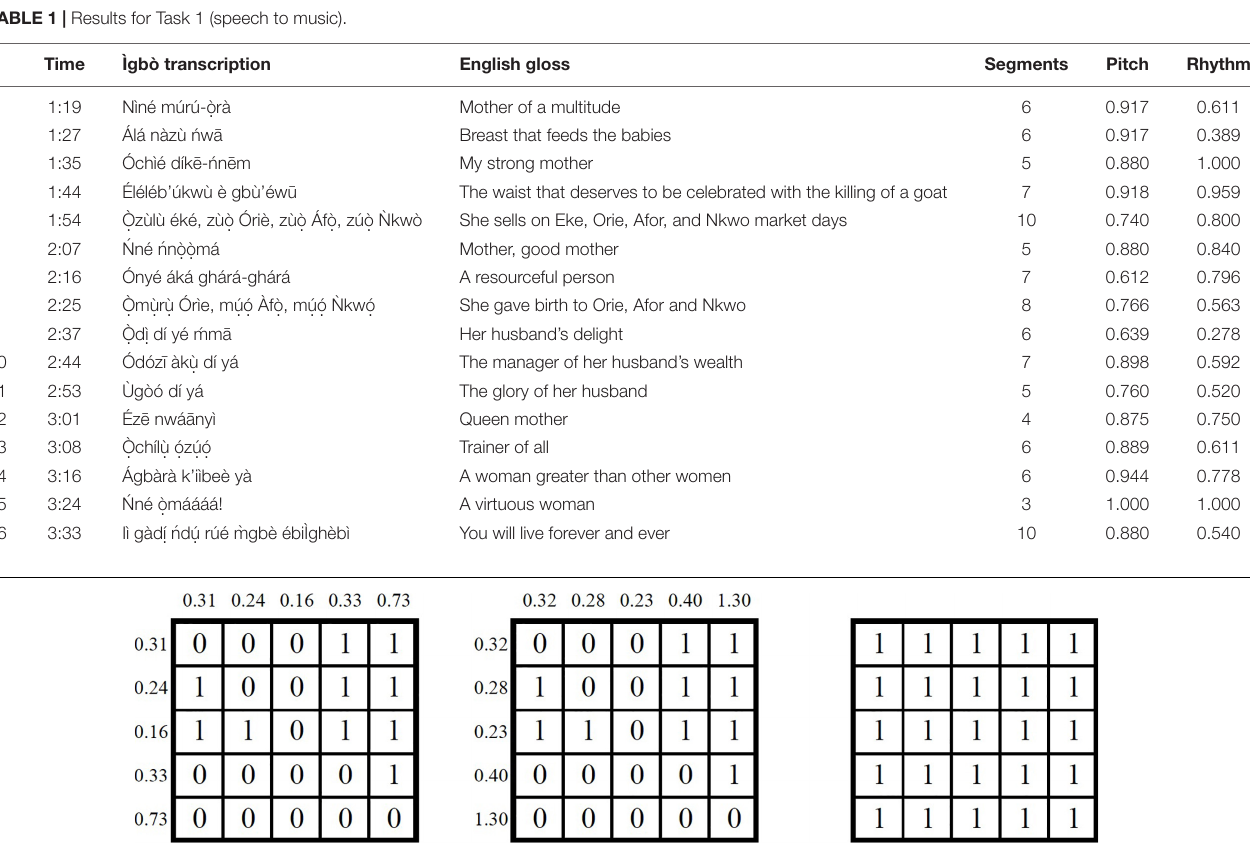
FIGURE 3 | Contour matrices for the rhythm of Task 1–Phrase 3 with male speech demonstration (left) , ò.jà interpretation (middle) , and similarity matrix (right) .